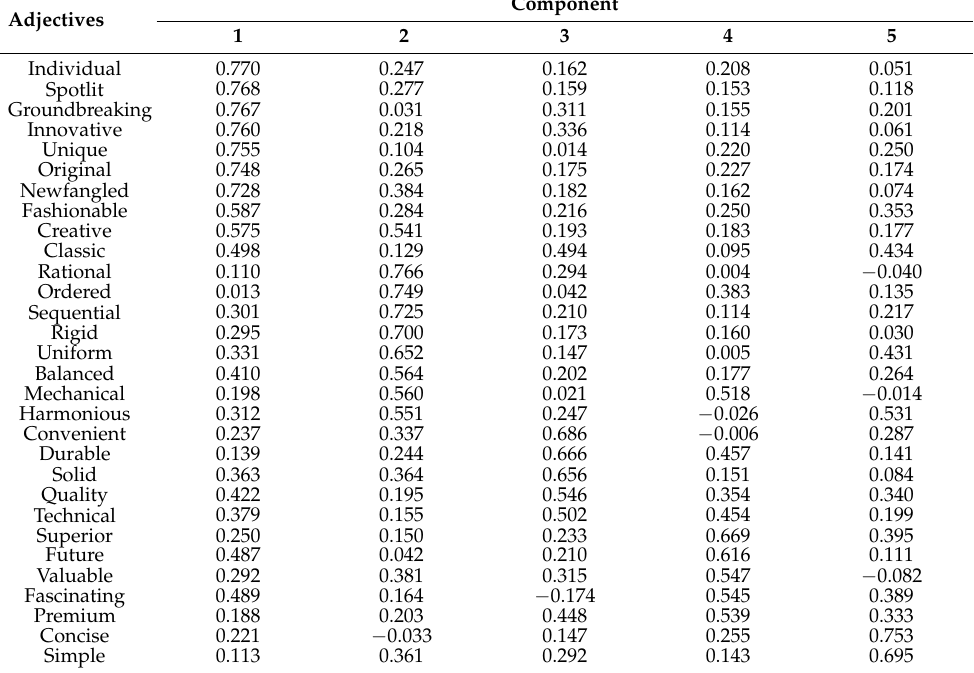
Table 8. Transformed component